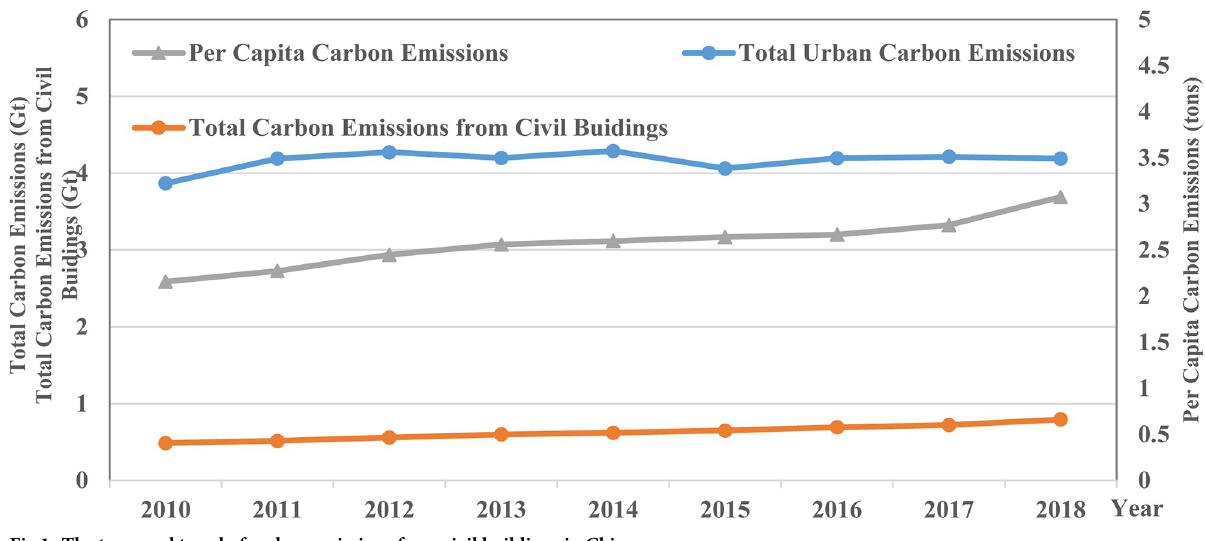
Fig 1. The temporal trend of carbon emissions from civil buildings in